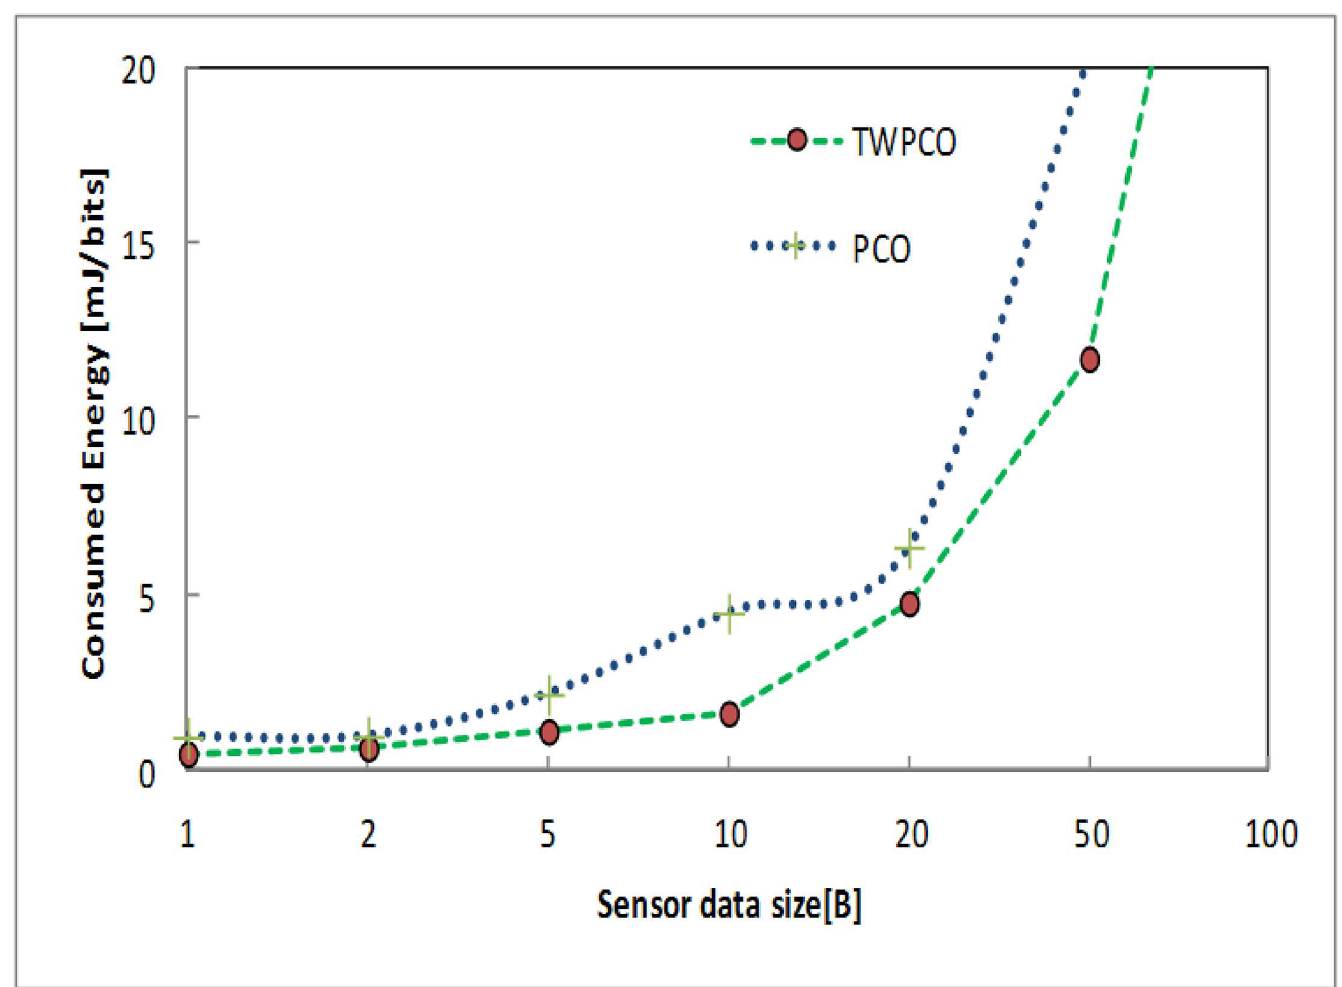
Fig 18. Energy efficiency ratio based on data packet